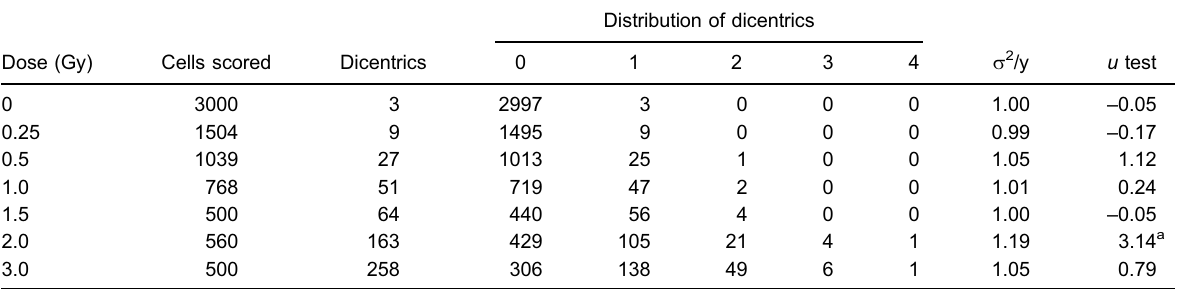
Table 2. Frequencies and distributions of dicentrics in human lymphocytes after acute LINAC X-ray irradiation with a range of doses. Distribution of